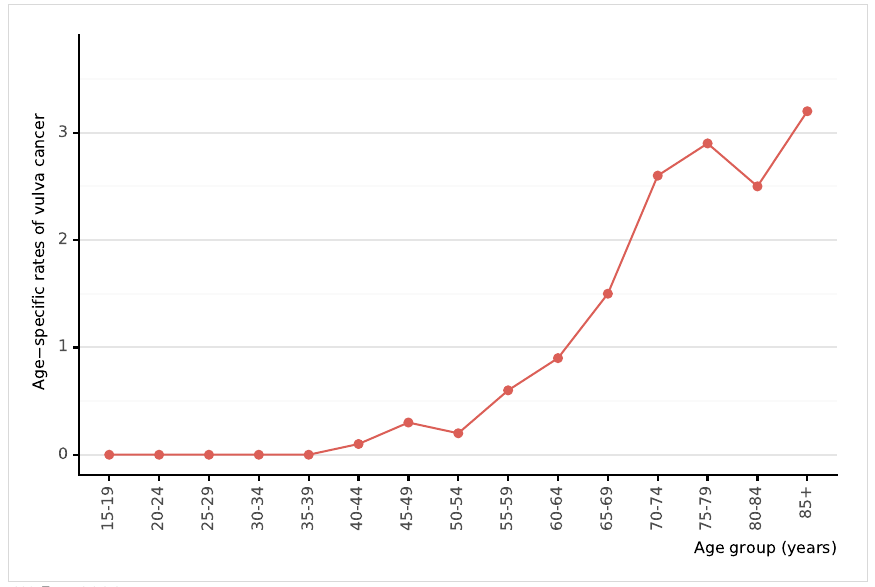
Figure 23: Age-specific mortality rates of vulva cancer in India (estimates for 2020)